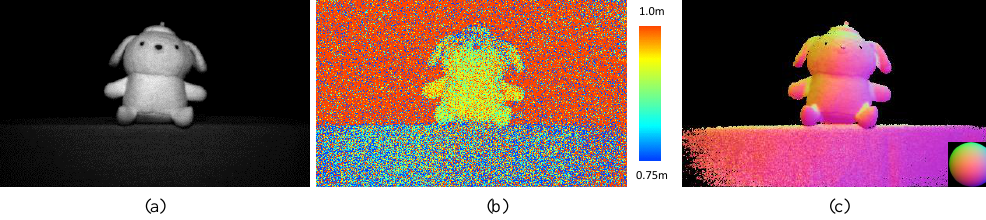
Figure 1. Comparison of time-of-flight (ToF) and photometric stereo methods. ( a ) shows the target scene. ( b , c ) show a depth map from the ToF method and a normal map from the photometric stereo method, respectively. The same image sensor was used for both methods. ( b ) shows the absolute depth of the object from the camera. The image noise affected the estimated depth directly and small structures were contaminated by the noise. ( c ) shows an object shape that is smoother and more detailed than that in ( b